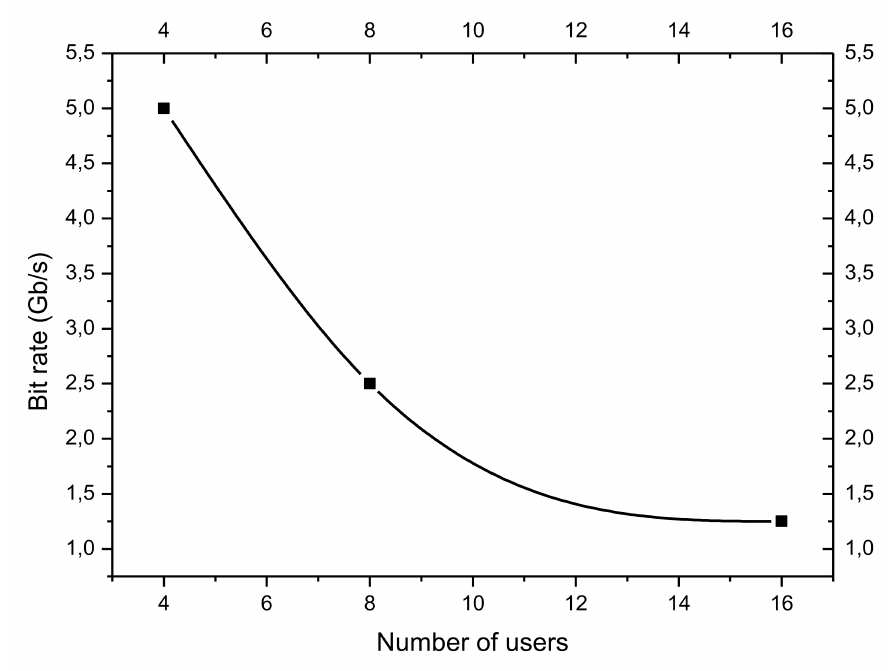
Figure 8. Bit rate versus the number of simultaneous users.